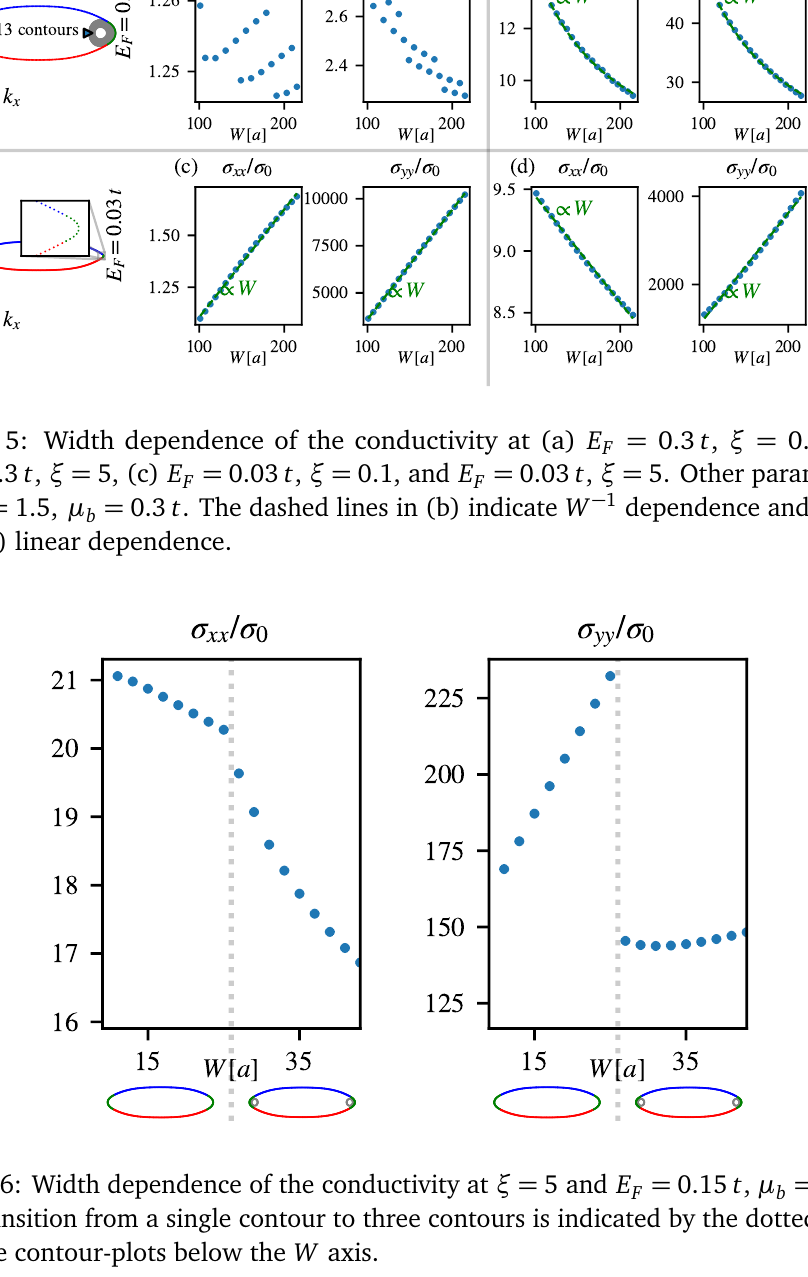
Figure 6: Width dependence of the conductivity at ξ = 5 and E The transition from a single contour to three contours is indicated by the dotted lines and the contour-plots below the W